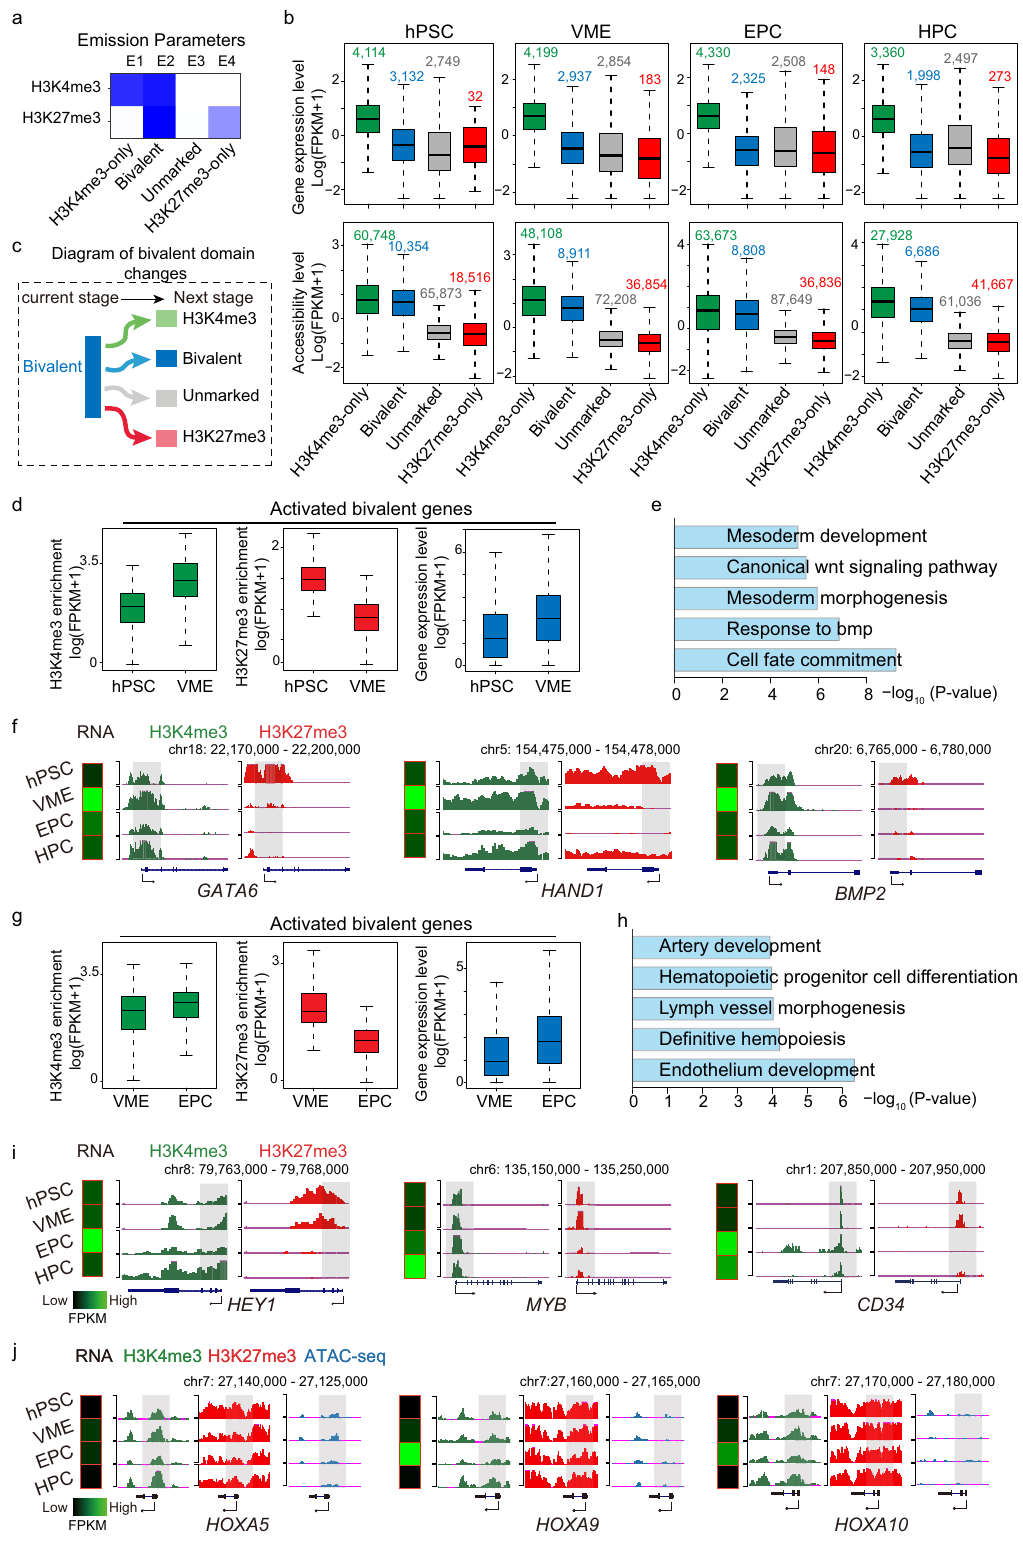
JUNB de fi ciency severely impairs HEC and HPC formation . To fi nd out the role of JUNB in HPC differentiation, we disrupted JUNB in HUES8 hESC using the iCRISPR system 47 (Fig. 7a). We selected two mutant lines (KO-1 and KO-2) for further studies. Sanger sequencing and western blot con fi rmed the deletion of nucleotides at the sgRNA targeting site of JUNB and the loss